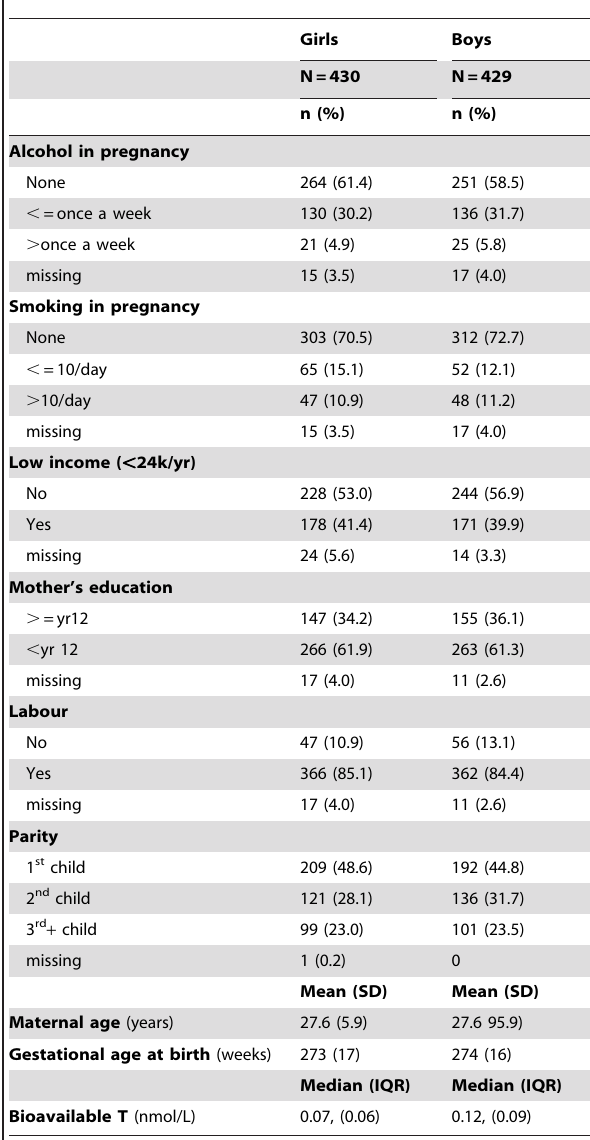
Table 1. Frequency characteristics of the sample predictor and control